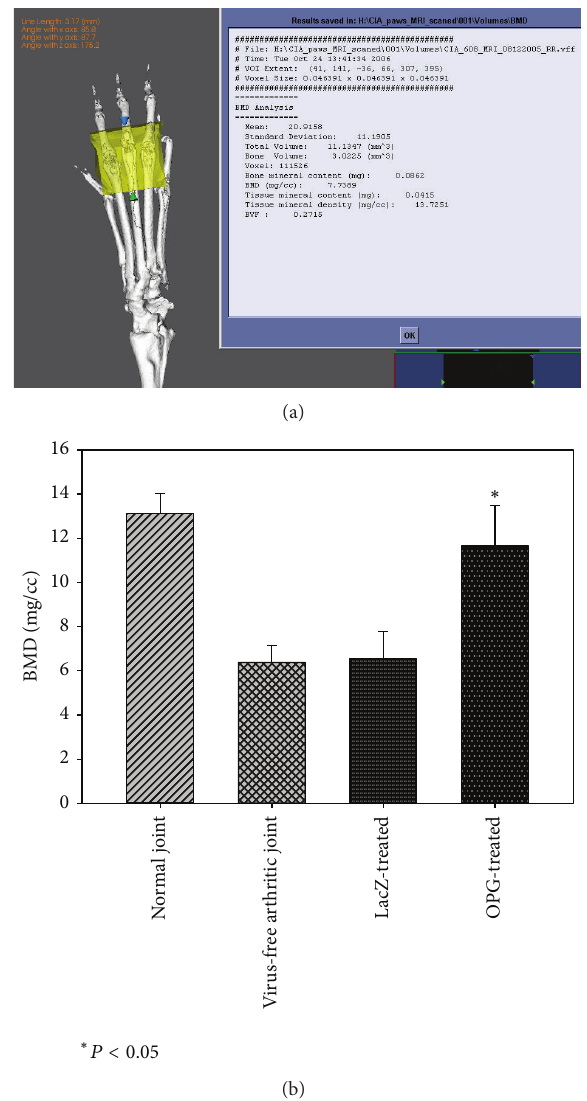
Figure 5: (a) GEHC MicroView software with Analysis + software to generate VOI on the 2, 3, and 4 metatarsal joints for BMD assessment.Panel(b)summarizesthebonemineraldensityreadings among groups. OPG gene transfer significantly preserved the sub- chondral BMD compared to the untreated and LacZ-gene controls ( 𝑃 < 0.05 ).